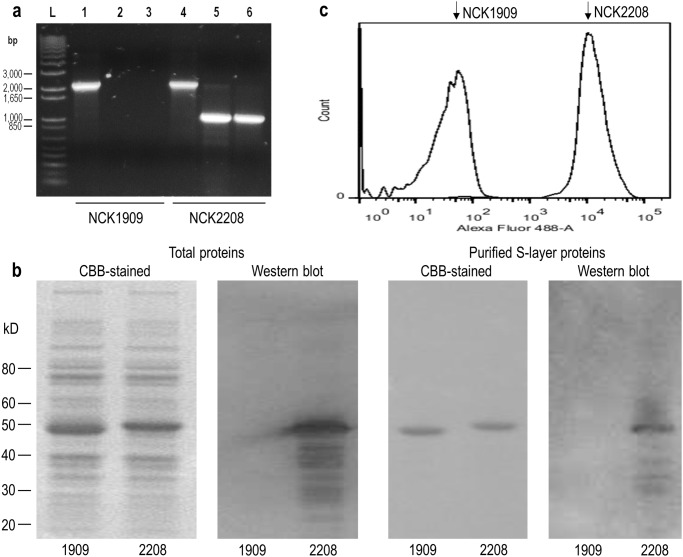
Validation of genetically modified L. acidophilus producing MPER-displaying S-layer proteins.The L. acidophilus slpA gene in NCK1909 was replaced with the modified slpA gene including MPER-encoding sequences by homologous recombination in NCK2208. (a) The gene replacement of slpA with the modified slpA was confirmed by PCR. L, DNA ladder marker. Amplified DNA fragments using primers, AK_62 and AK_65 (lane 1 and 4), AK_62 and AK_57 (lane 2 and 5), or AK_56 and AK_65 (lane 3 and 6). (b) Detection of the MPER epitope in S-layer (SlpA) protein using 2F5 mAb. Total cell proteins and purified S-layer proteins of NCK1909 and NCK2208 were separated by SDS-PAGE. The gels were stained with CBB or blotted onto PVDF membrane followed by western blot analysis using 2F5 (anti-MPER monoclonal human IgG). (c) The exposed MPER epitope was detected by flow cytometry. The L. acidophilus strains labeled with 2F5 and Alexa Fluor 488-conjugated anti-human IgG were analyzed. Relative fluorescence intensity of each strain was shown as histogram plot.